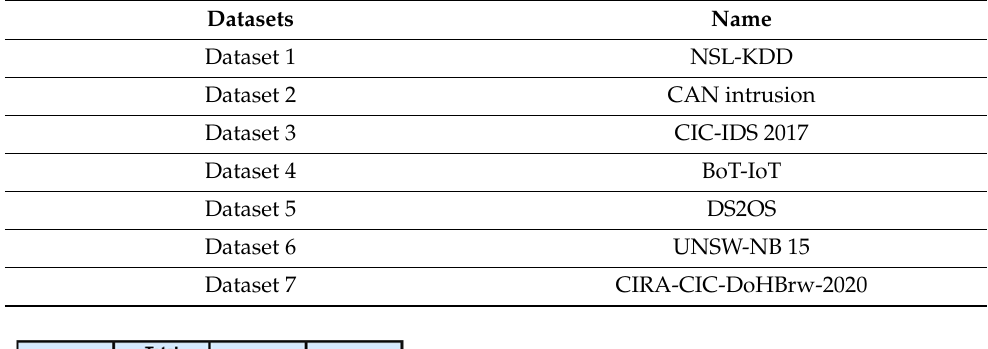
Table 2. Datasets used for analysis.